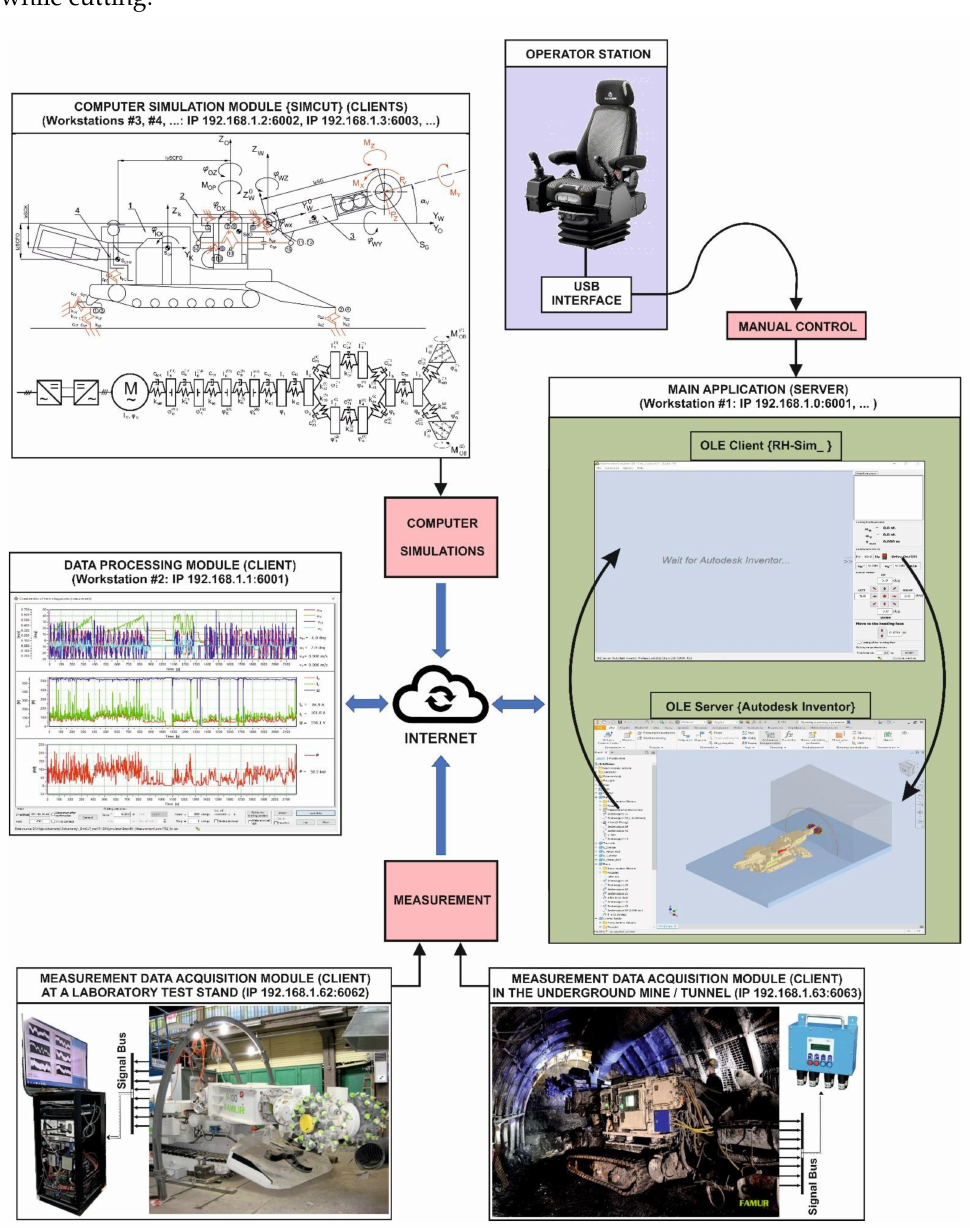
Figure 5. Schematic diagram of a roadheader research